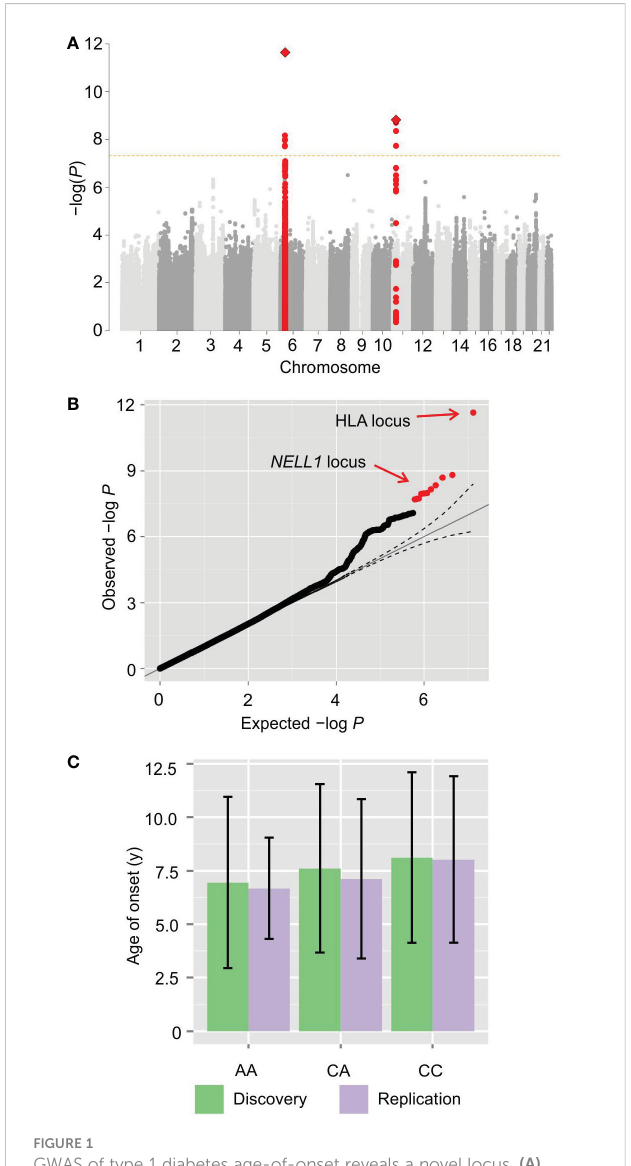
lymphoma cells. The lower posterior probability SNP, rs7104612, did not show a shifted DNA-protein complex for either allele. Only the risk allele (A) of the higher posterior probability SNP, rs10833518, bound a high-molecular weight protein complex (Figure 2). The surrounding sequence that contains rs10833518 does not match a known binding motif for a transcription factor, therefore we cannot ascertain the identity of the nuclear proteins making up the complex.